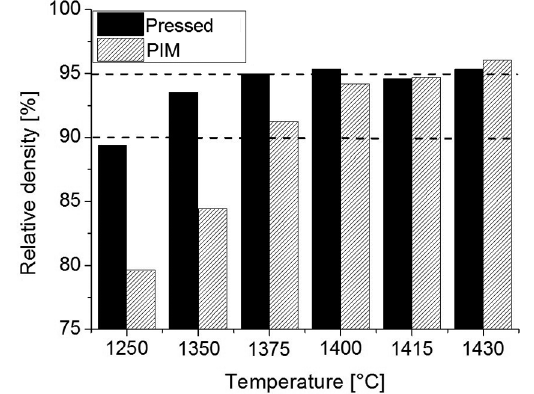
Figure 5. Final density for pressed and injection molded samples after sintering at temperatures between 1250°C and